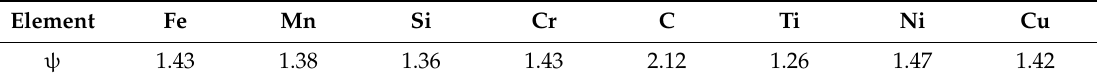
Table 3. Atomic radius ratio ψ between Ce and alloy